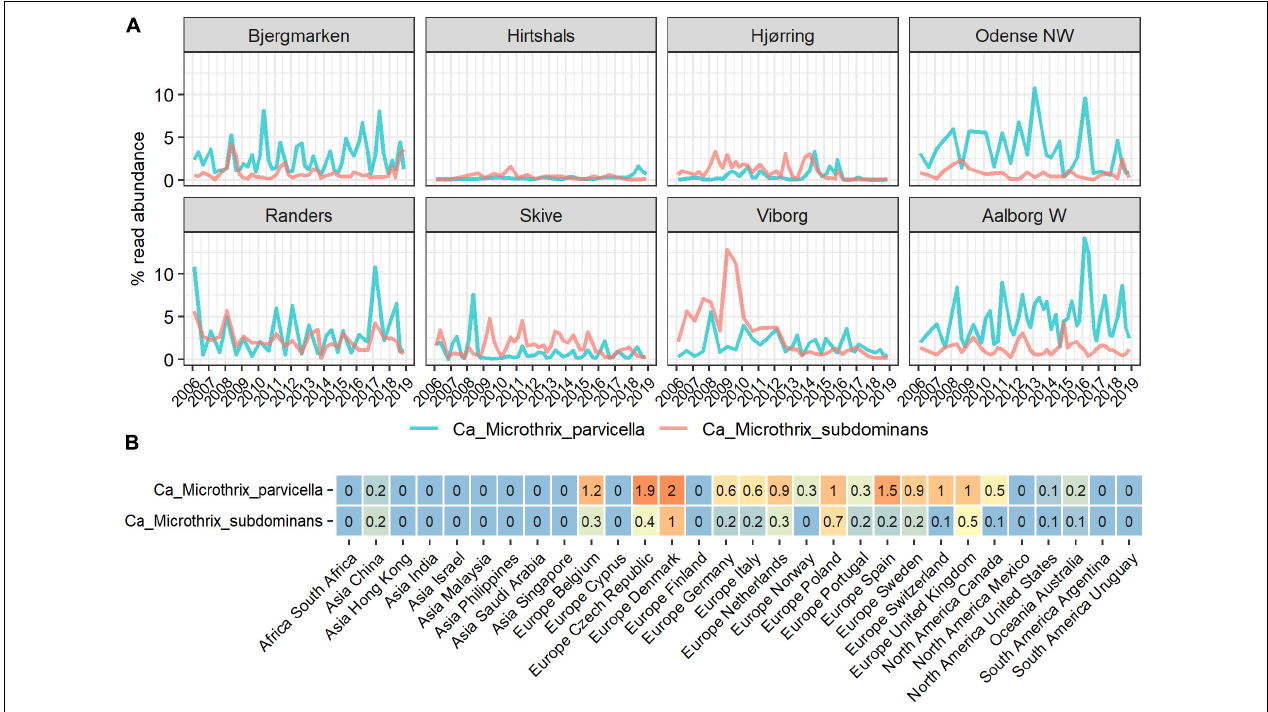
FIGURE 1 | Abundance of Ca. Microthrix species in full-scale activated sludge plants in (A) Denmark and (B) globally, shown by country. The Danish data (A) represents a subset of the long-term survey of microbial communities in years 2006–2018 (Nierychlo et al., 2020a) containing 311 samples from 8 nutrient removal WWTPs. The global data (B) represents average abundances per country of a total of 847 activated sludge samples from 438 plants with four different process designs (carbon removal, carbon removal and nitrification, carbon removal, nitrification and denitrification, and EBPR